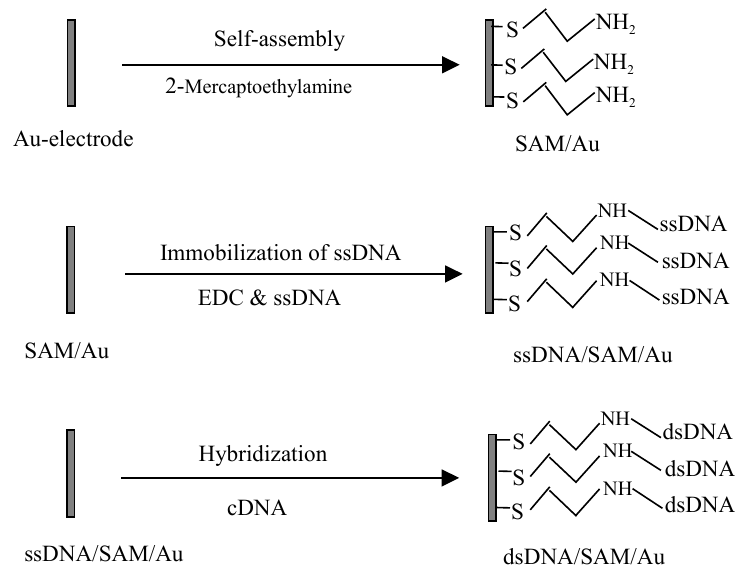
Figure 1. The preparation procedure of DNA